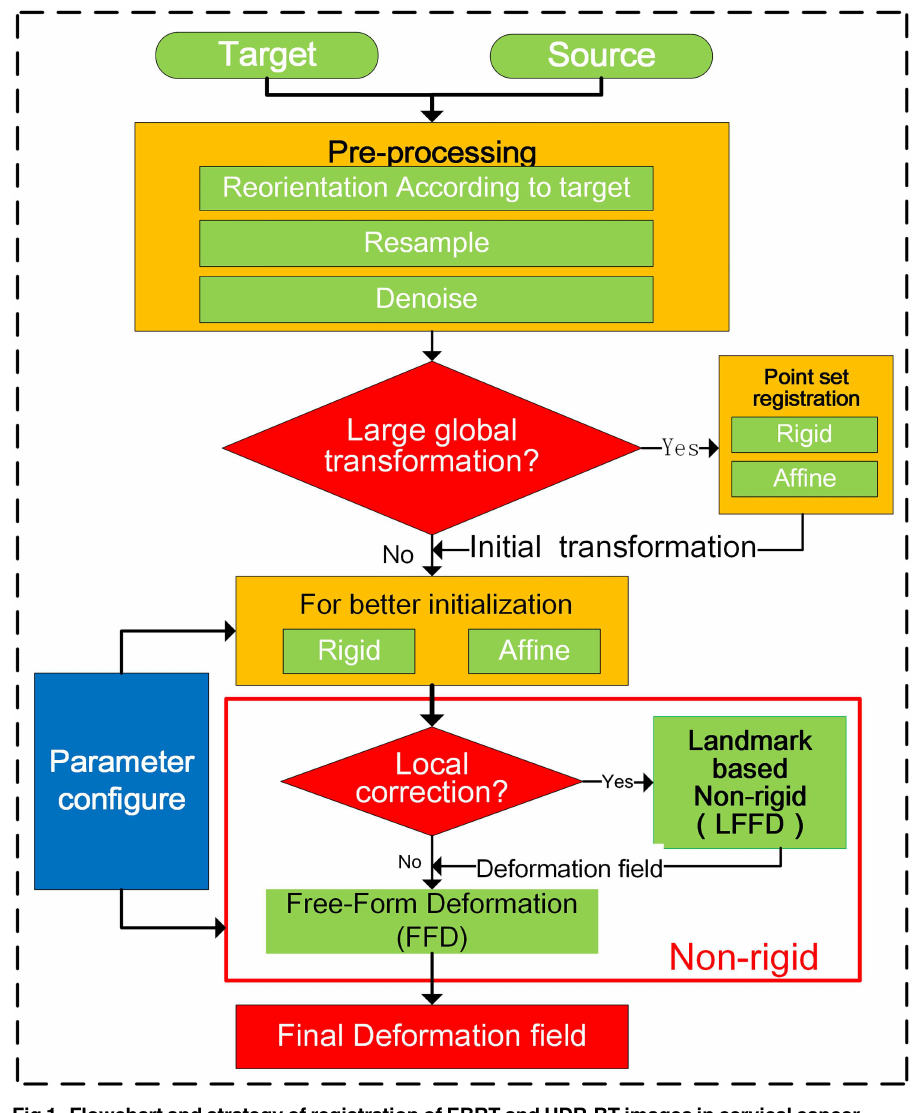
Fig 1. Flowchart and strategy of registration of EBRT and HDR-BT images in